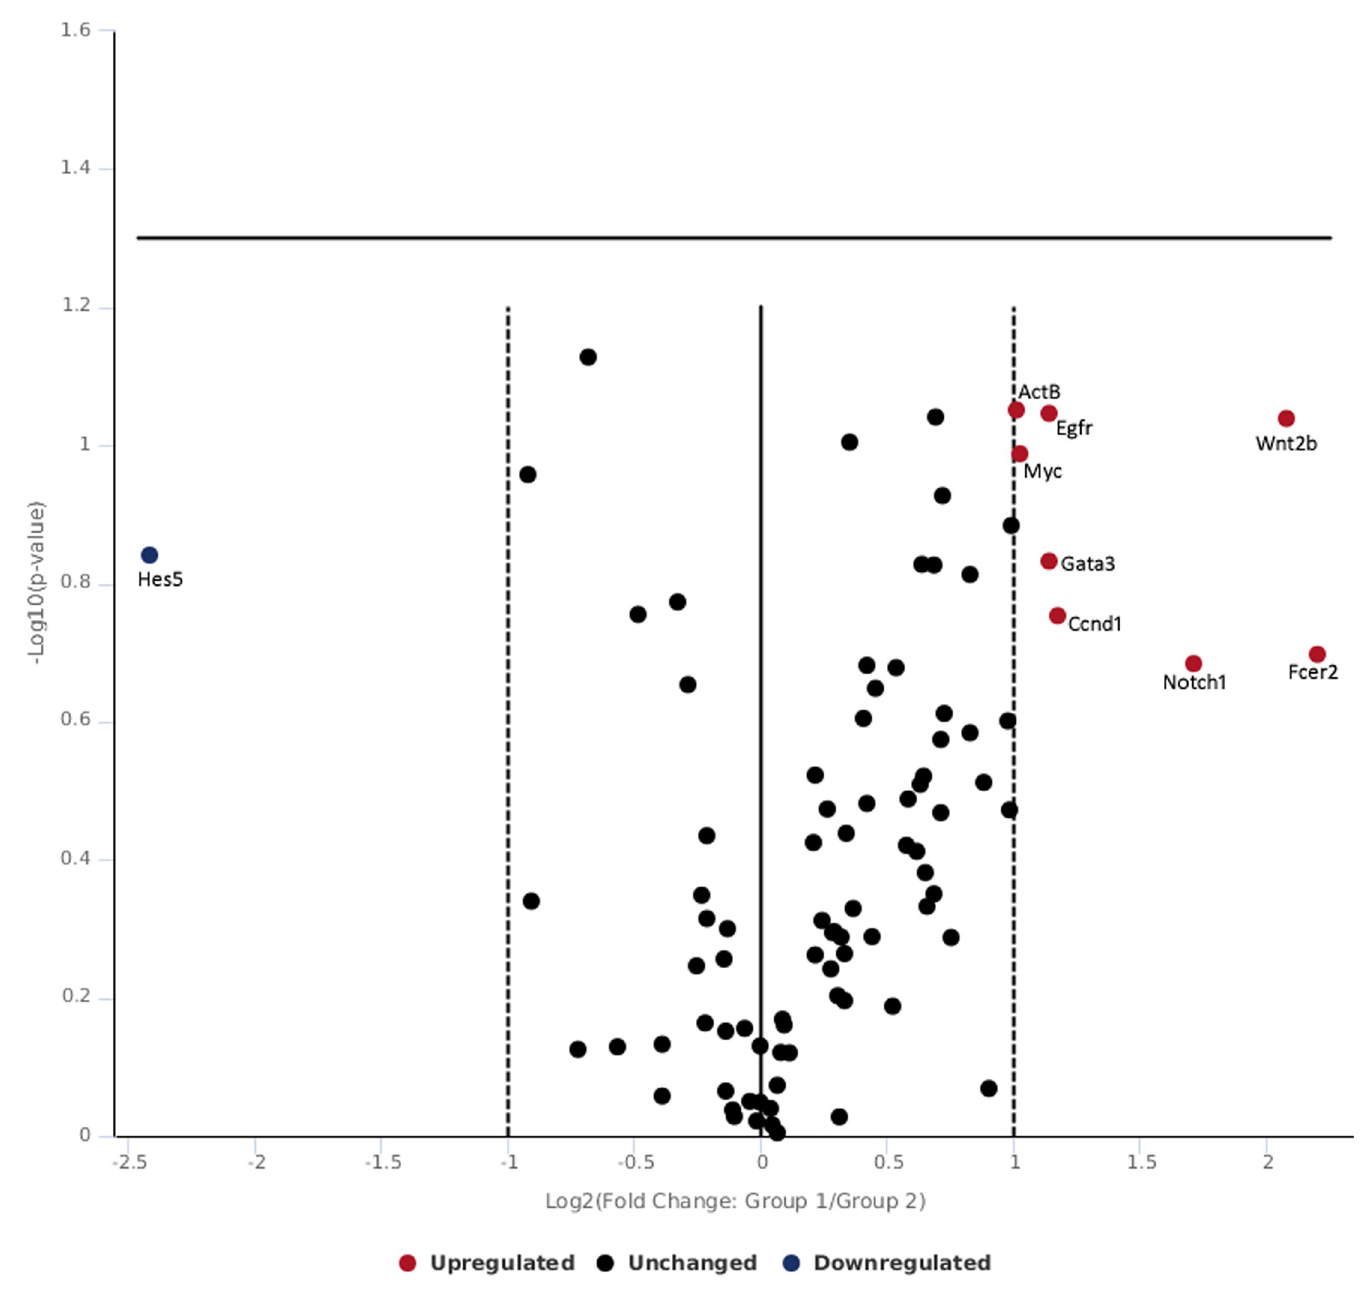
Fig 6. Volcano plot of intergroup comparison of genes expressed following 532 nm laser exposure at low irradiance (0.10 W/cm 2 ) and moderate irradiance (0.25 W/cm 2 ).